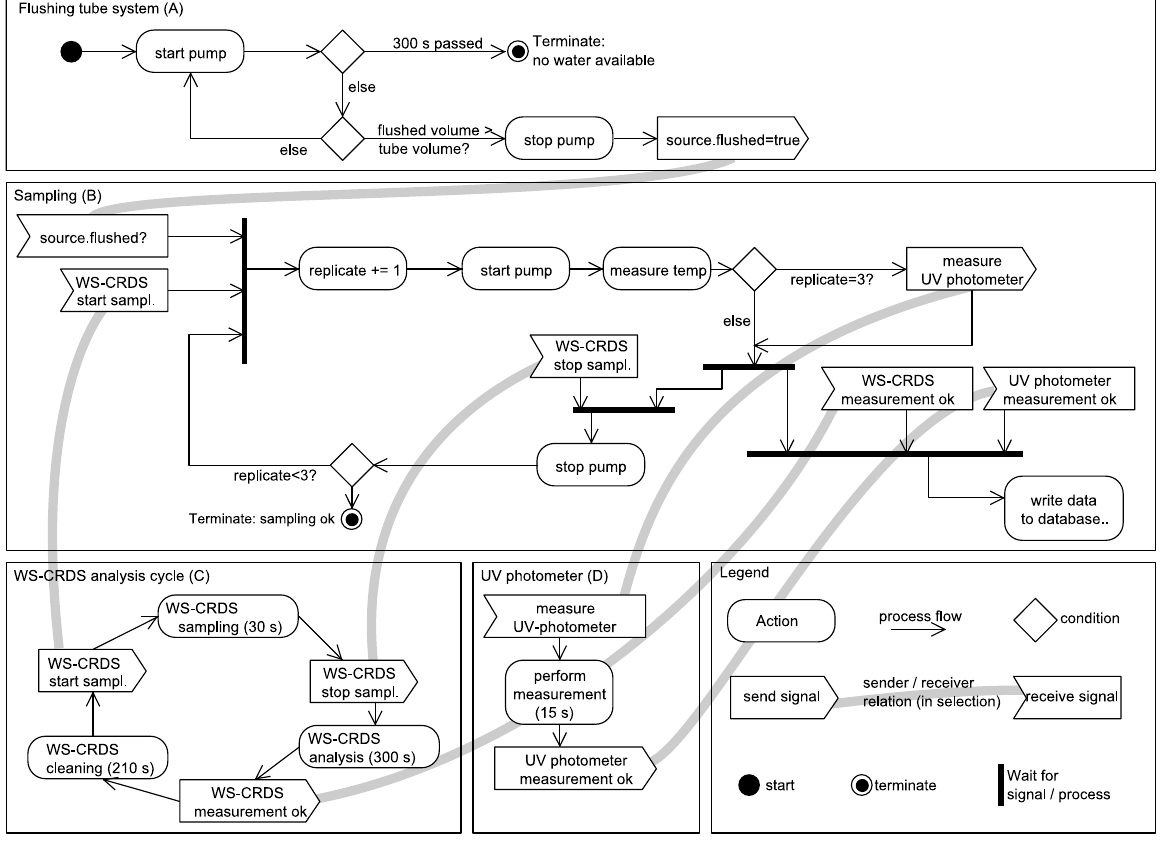
Figure 6. UML2 activity diagram of the sampling sequence with isotopic analysis. Each communication with external devices is asynchronous to check for errors or non-responding devices. Additional checks to preserve the pumps from running dry are omitted in the diagram. Non-responsive modules/devices are checked with time-out constraints (not shown for